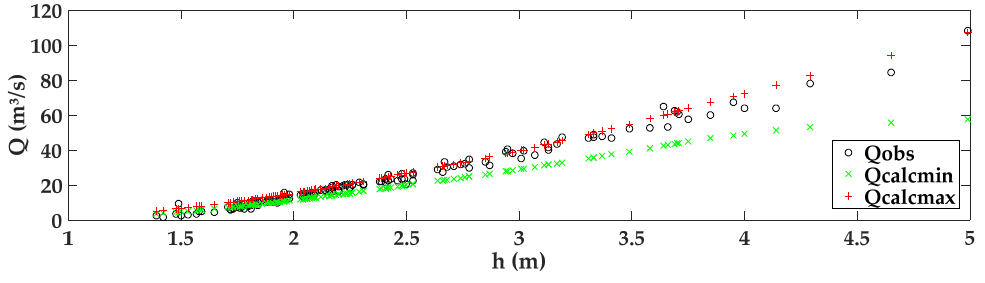
Figure 6. Interval of calculated and observed discharges—GLUE.